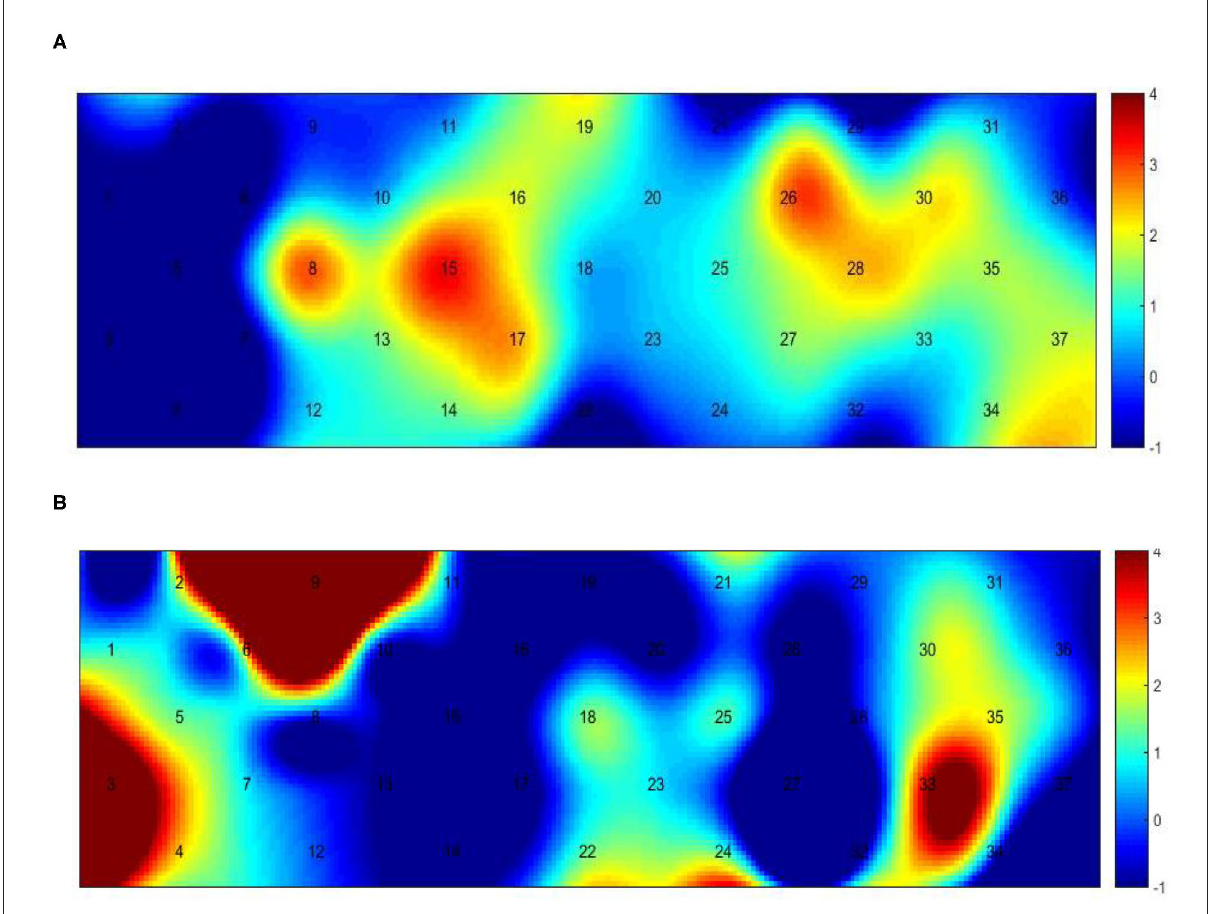
FIGURE5 Between-group variance of channel activation t-map in the gait task ( p < 0.05, uncorrected). (A) The variance of healthy and hemiplegic treadmill walking. (B) The variance of hemiplegic treadmill walking with or without FES